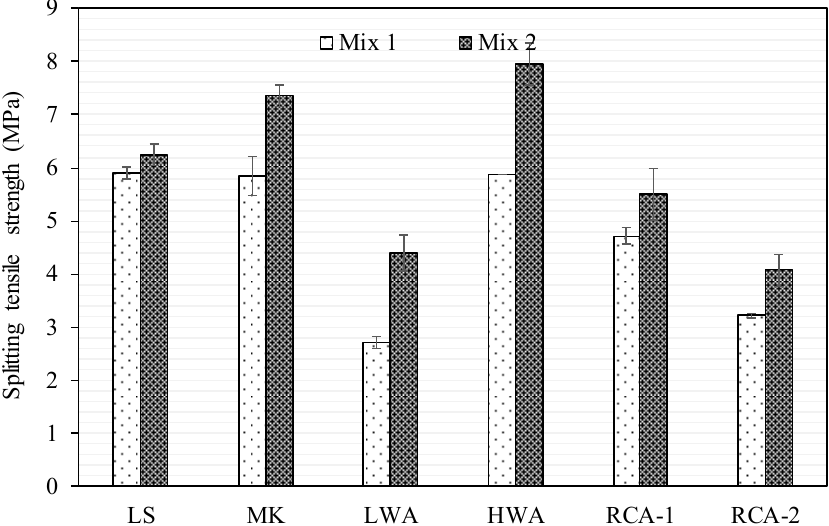
Figure 5. Splitting tensile strength results for Mix 1 and Mix 2.